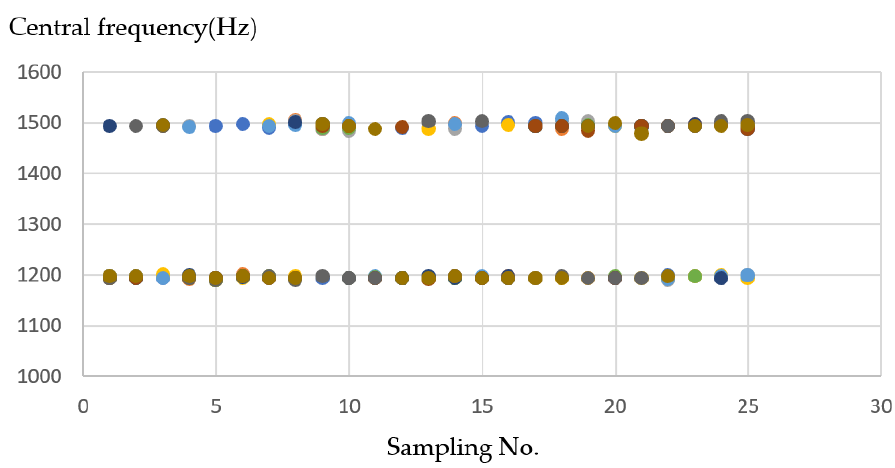
Figure 16. Ten sample frequency results from clustering by K-means for wood material.